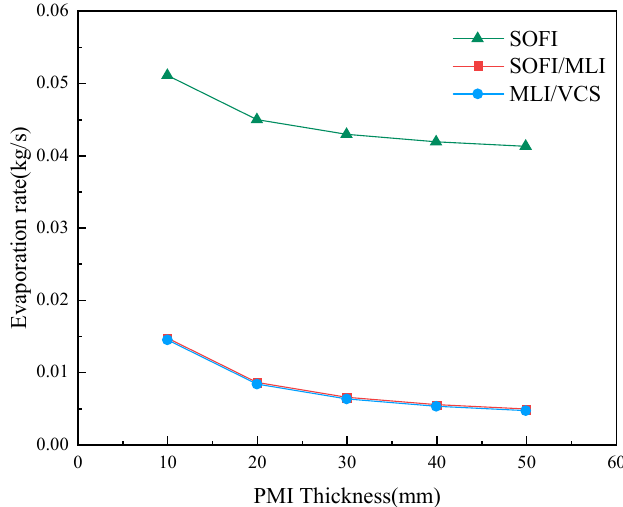
Figure 8. Liquid hydrogen evaporation under di ff erent adiabatic conditions.